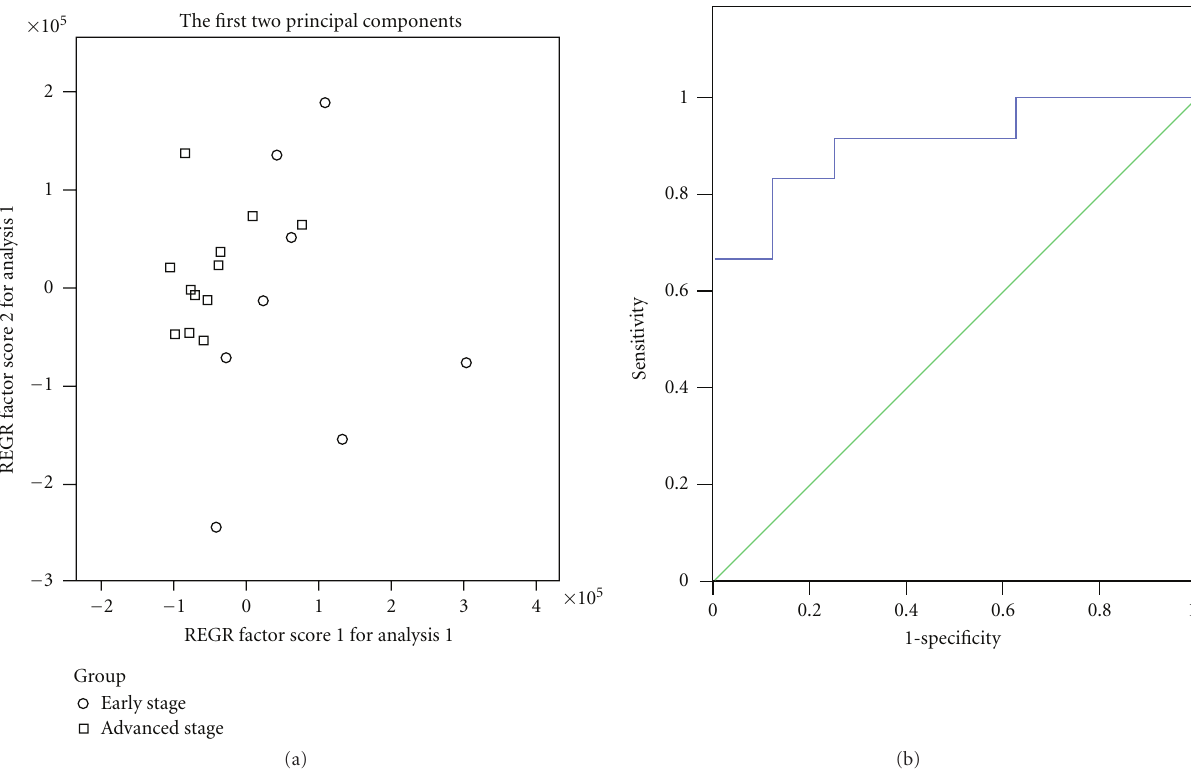
Figure 4: Principal component analysis model and receiver operating characteristic curve for advanced colorectal cancer. (a) Principal component analysis (PCA) scores plot of early stage group and advanced group based on 2 marker metabolites. The PCA scores plot showed that the samples from early stage group and advanced group were scattered into two di ff erent regions; (b) receiver operating characteristic (ROC) analysis was performed using the values determined by the first two principal components. Area under the curve (AUC) =